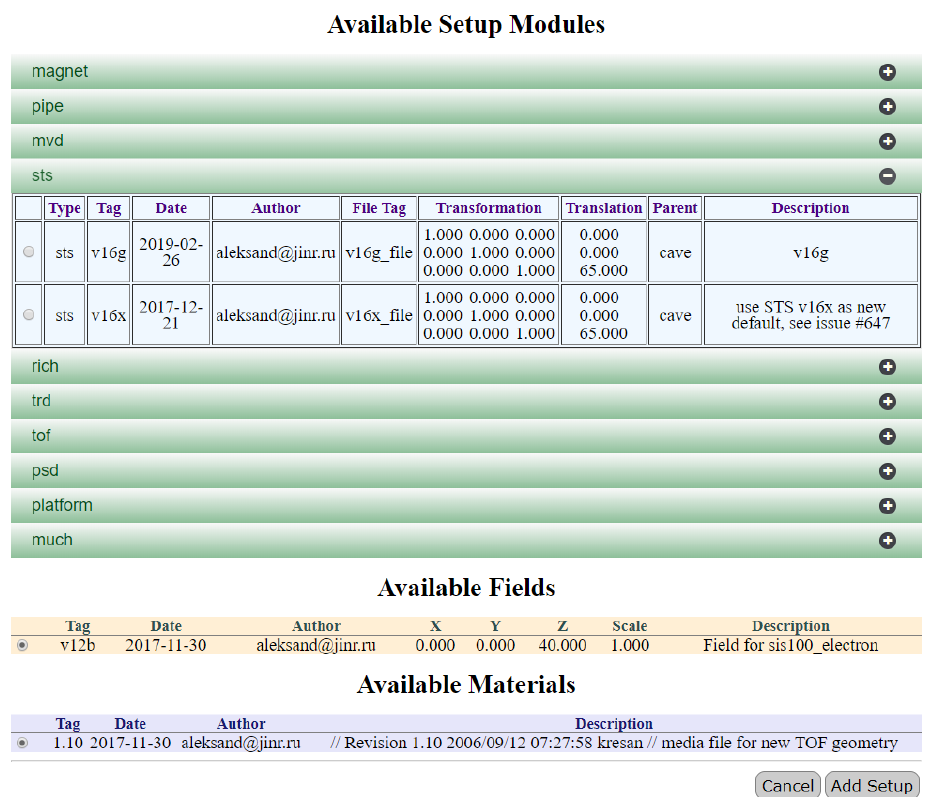
Fig. 5. Web-interface fragment: View Mode.